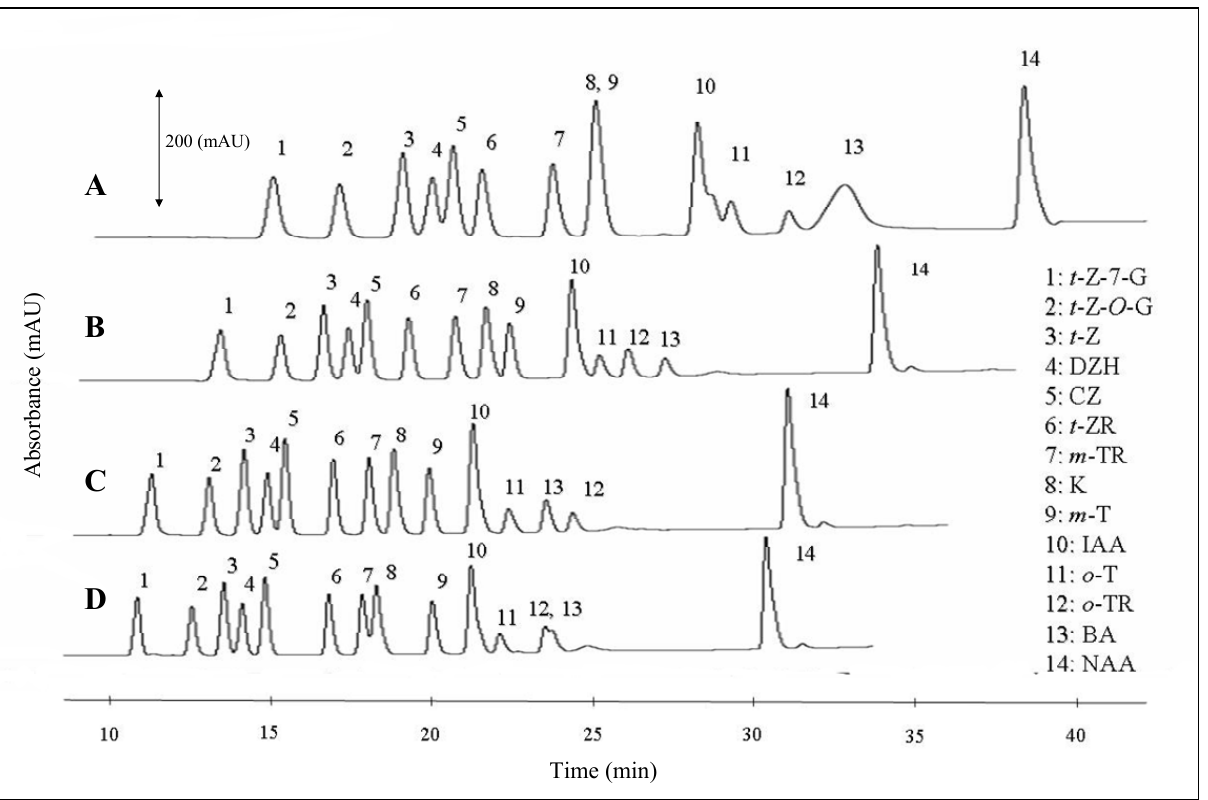
Figure 5. Typical HPLC-UV chromatograms of phytohormones measured at four